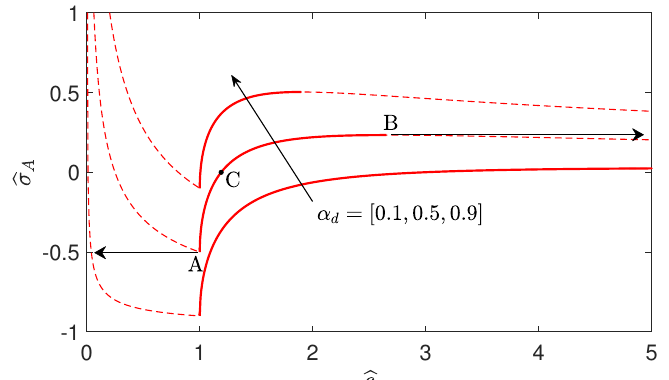
Figure 2. Remote stress (cid:98) σ A versus the crack radius (cid:98) c in the McMeeking et al. [17] elastic model for α d = [ 0.1,0.5,0.9 ] . For the curve α d = 0.5, point “C” determines the equilibrium position ( (cid:98) σ A = 0 ) , point “B” the “weak” adhesive state, while point A is the point where the jump to full contact